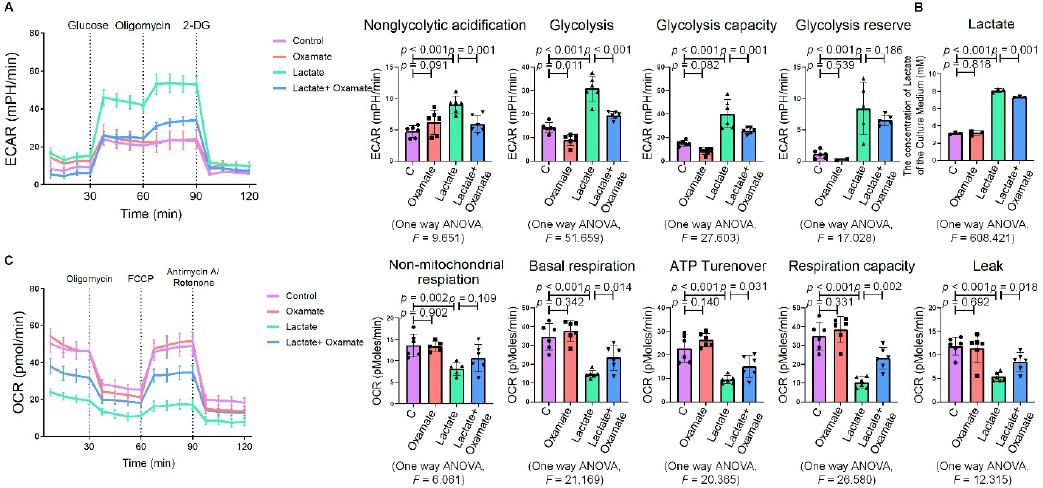
Figure 6. Oxamate attenuated the lactate-induced enhancement of glycolysis in macrophages. ( A ) Glycolysis flux was examined by measuring the ECAR using the Seahorse analyzer. Data are presented as the mean ± SD, n = 6 per group. ( B ) The lactate content in the culture medium was detected using a lactate assay kit. Data are presented as the mean ± SD, n =3 per group. ( C ) The OCR values were measured using the Seahorse analyzer. Data are presented as the mean ± SD, n = 6 per